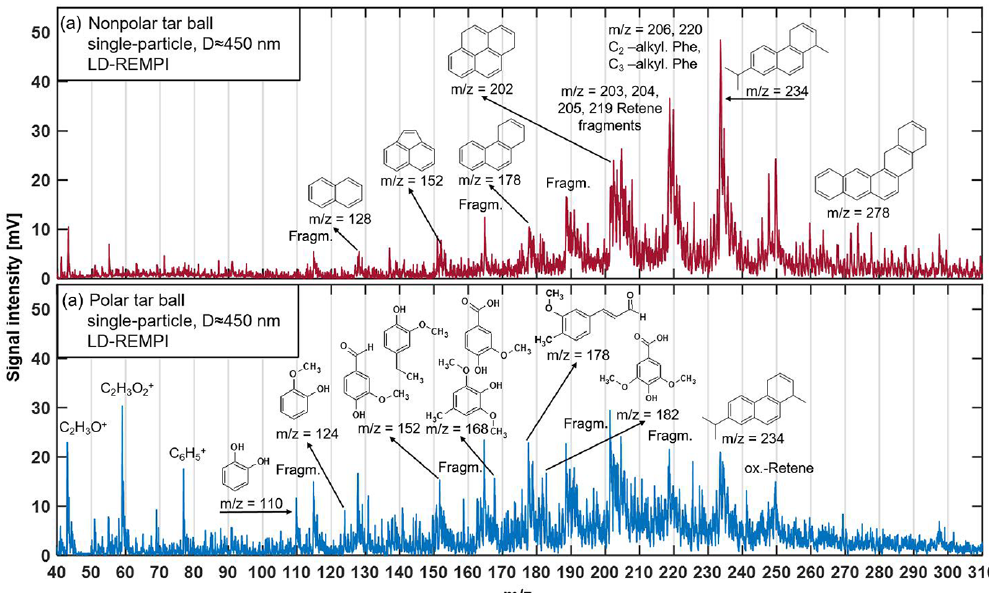
Figure 3. LD-REMPI mass spectra of exemplary single tar ball particles; some feature peaks were identified and labeled. (a) Nonpolar tar ball spectra show predominantly alkyl-substituted and unsubstituted PAHs. (b) Polar tar ball spectra reveal many oxidized aromatics, e.g., methoxy-phenol and benzenediol. Note the softwood combustion marker retene at m/z = 234, its characteristic fragments ( m/z = 203, 204, 205, 219), and possible retene derivatives ( m/z = 248,